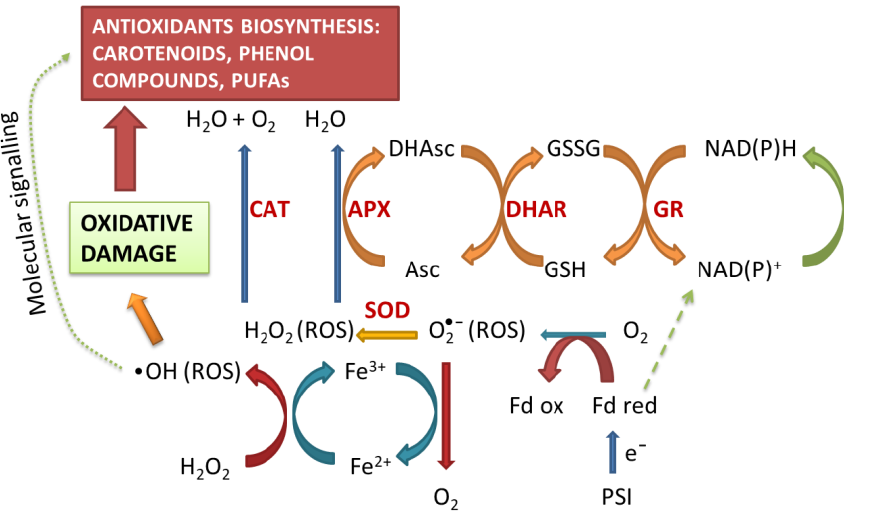
Figure 1. Reactive oxygen species (ROS) formation and antioxidant enzymatic system in microalgae. GSSG: oxidized glutathione; GSH: reduced glutathione; NADP (+,H): nicotinamide adenine dinucleotide phosphate (oxidized, reduced); Asc: reduced ascorbate; DHAsc: dehydroascorbate; CAT: catalase; SOD: superoxide dismutase; APX: ascorbate peroxidase; DHAR: dehydroascorbate reductase; GR: glutathione reductase; Fd red: reduced ferredoxin, with electrons from PSI; Fd ox: oxidized ferredoxin.